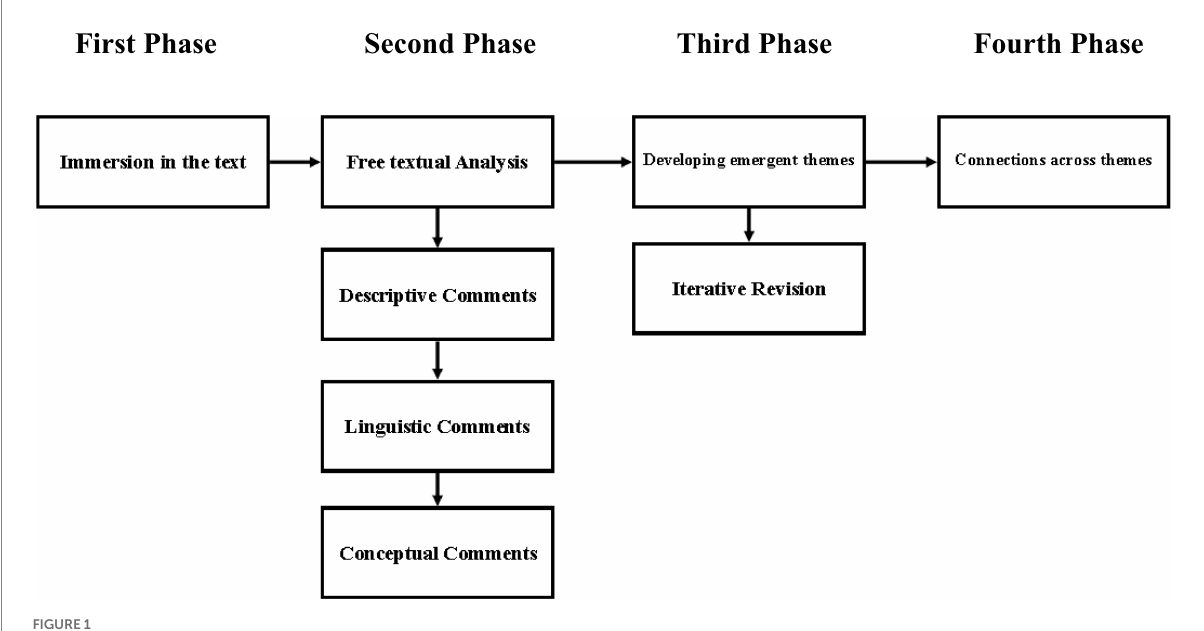
FIGURE 1 Overview of the analytic